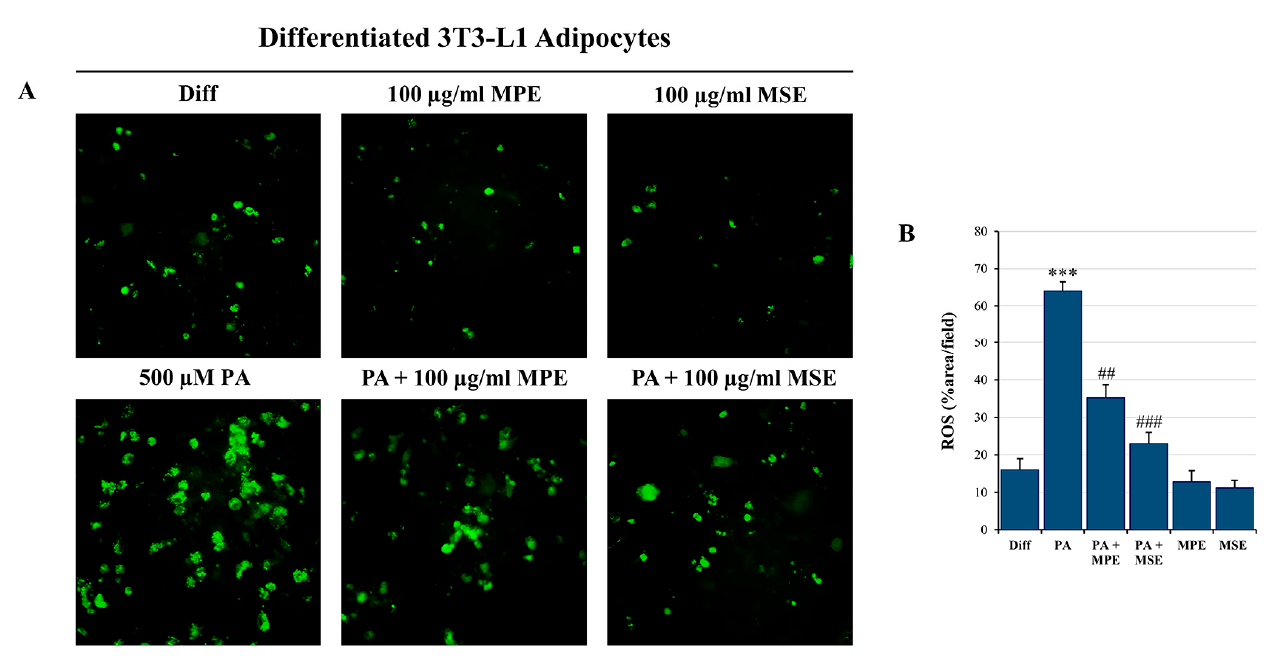
Figure 6. MPE and MSE reduce PA-induced oxidative stress in 3T3-L1 adipocytes, reducing ROS production. Intracellular ROS detection was performed by redox-sensitive fl uorochrome H 2 DCFDA. Di ff erentiated 3T3-L1 adipocytes were treated with 500 µM PA for 48 h in the presence or absence of 100 µg/mL MPE or MSE, as reported in Section 4. Then, cells were incubated with 10 µM H 2 DCFDA solution for 30 min at 37 °C. The oxidation of the fl uorochrome-generated green fl uorescence was visualized by a Leica microscope equipped with a DC300F camera using a FITC fi lter. ( A ) Representative images of fl uorescence microscopy were taken at 200× magni fi cation. ( B ) ROS content was ascertained by analyzing the percentage area with Image J. *** p < 0.001 was sig- ni fi cant with respect to di ff erentiated 3T3-L1 adipocytes, and ## p < 0.01, ### p < 0.001 were sig- ni fi cant with respect to PA-treated 3T3-L1 adipocytes.